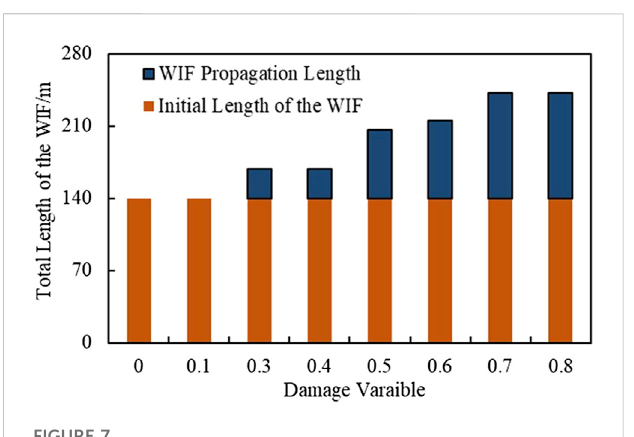
FIGURE 7 WIF propagation length with different damage variables.